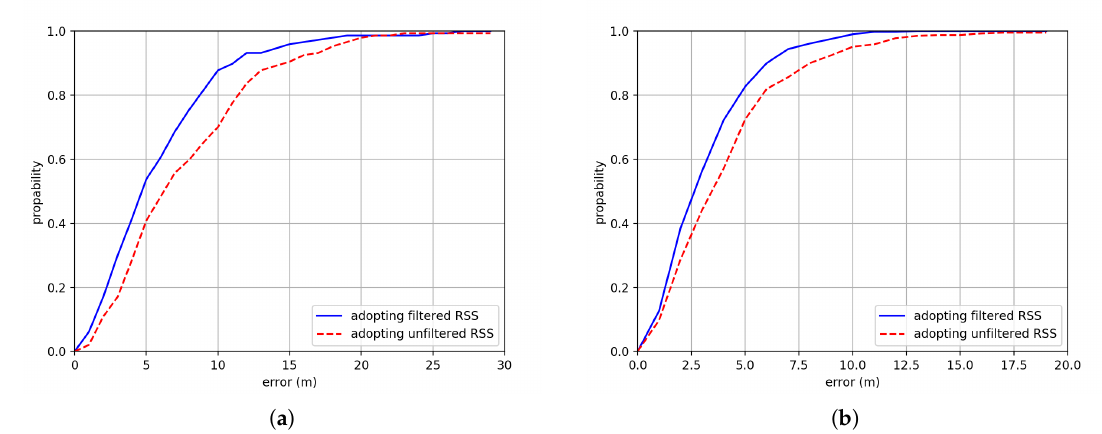
Figure 11. The Cumulative Density Function (CDF) comparison between adopting filtered RSS and unfiltered RSS in ( a ) Building One and ( b ) Building Two.